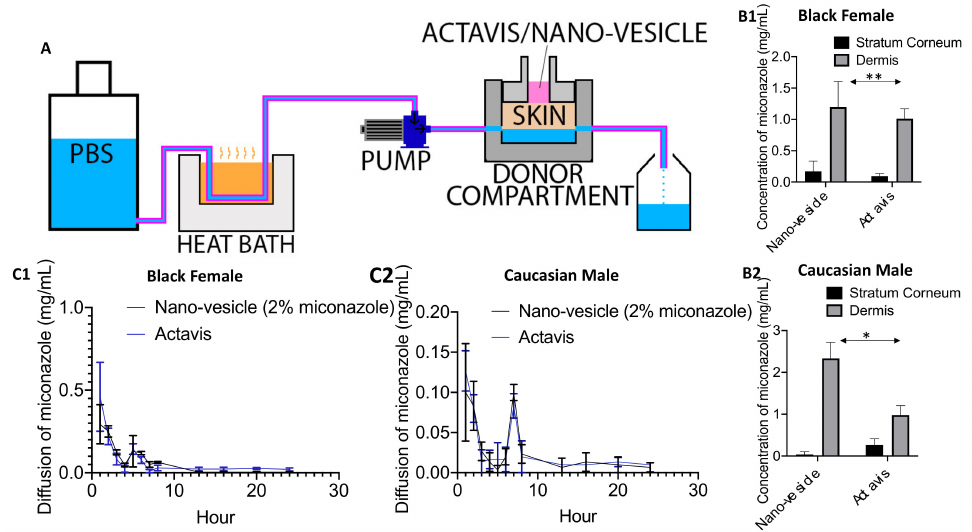
Figure 4. ( A ) Diagram of the PermeGear Franz di ff usion cell system. PBS is warmed to 37 ◦ C before being pumped into the donor compartment, underneath the skin, and finally resides in the scintillation vial, which was changed hourly. ( B1 , B2 ) UV-Vis comparing the amount of miconazole located within the stratum corneum and lower dermal layers after 24 h in the PermeGear di ff usion system. ( C1 , C2 ) Hourly readings of the PBS collected scintillation vials, identifying the amount of drug that may pass completely through the skin and into the bloodstream within 24 h. All data are presented as mean ± SE ( n = 6). * p < 0.05; ** p < 0.01 compared with the